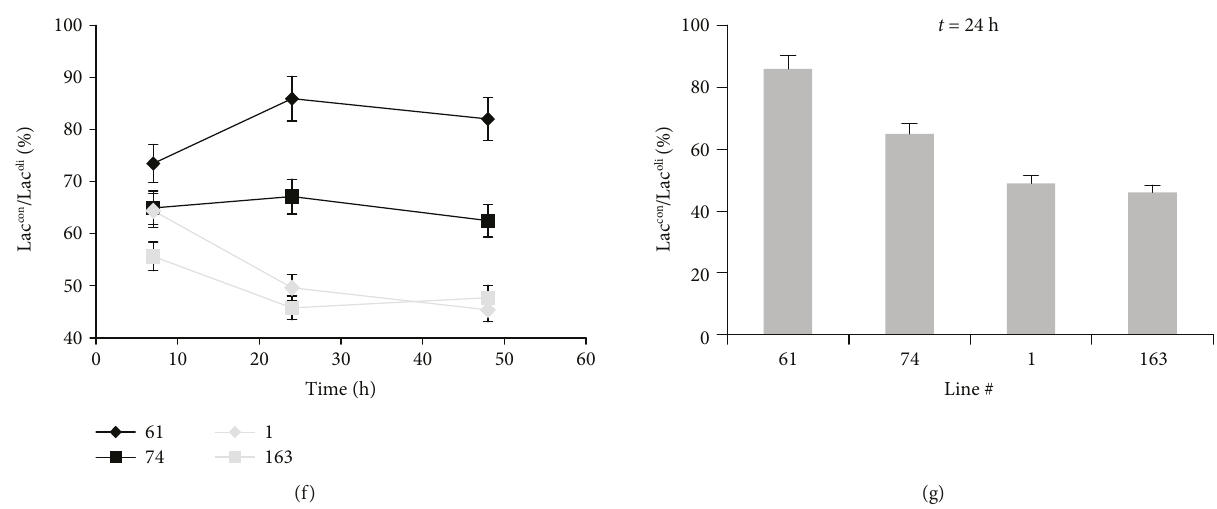
Figure 6: Analysis of the e ff ects induced by oligomycin treatment. (a) Ratios of fl uorescence signal values of treated samples (FL1 and FL2 oligomycin) and those of control ones (FL1 and FL2-C). Trend of ML (b) and PC + GPC (c) signal intensities from 1D spectra of control and oligomycin-treated #61, #74, #1, and #163 line samples. Percentage variation of cell number (d) and lactate signal intensity, measured − (Lac/N) with respect to cell number [(Lac/N) ]/(Lac/N) , after 24 h oligomycin treatment (e) Representative spectra of line #163 oli con con after treatment are reported in Figure S3C. (f) Ratio of lactate signal intensity of control (Lac con ) and olygomicin-treated samples (Lac oli ) as a function of time. (g) Values after 24 hours of treatment are reported for all the analyzed